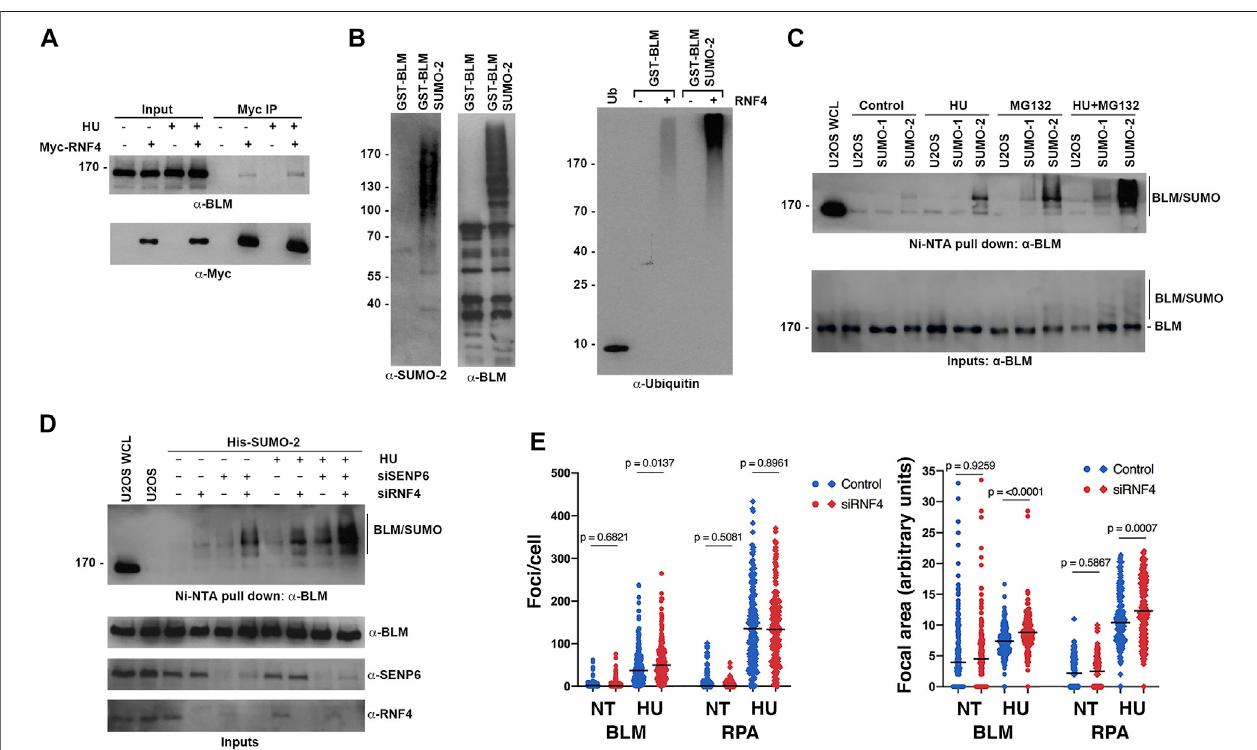
FIGURE 5 | RNF4 modulated BLM levels at sites of replication stress. (A) HeLa cells were transfected with Myc-tagged RNF4 and cultured in the presence or absenceofHU. RNF4wasimmunopuri fi edfrom celllysates and protein complexes wereanalyzed byimmunoblotanalysiswithanti-Mycand anti-BLMantibodies. (B) A puri fi edGST-taggedN-terminalfragmentofBLM(aminoacids1-431)modi fi edbySUMO-2 invitro isubiquitylatedbyRNF4 invitro whereasunmodi fi edBLMisnot(right panel). Ubiquitin alone (Ub). Input levels of GST-BLM and GST-BLM-SUMO2 were determined by immunoblot analysis (two left panels). (C) Levels of SUMO-BLM increasewith2 mMHUtreatmentfor12 h,treatmentwithMG132for3 hours,ortreatmentwithHUfor12 hfollowedbyMG132for3 h.Pull-downswithNi-NTAagarose beads wereperformedin U2OScells thatexpress aHis-tagged SUMO1 orSUMO2. U2OS WCL (cid:1) control U2OSwhole celllysate. (D) Levels ofSUMO-BLMincrease in U2OScellsdepletedofRNF4,SENP6,orboth,inresponseto2 mMHUfor12 horintheabsenceoftreatment.Ni-NTApull-downsshownasin (C) . (E) ExcessBLMand RPAproteins accumulatedat collapsed forks inRNF4-depleted HeLacellstreatedwith2 mMHU for16 h compared tocontrol-depletedcells. Leftpanel, enumerations of BLM and RPA foci. Right panel, quanti fi cations of focal areas of BLM and RPA foci. Results from three independent experiments were combined. NT, not treated.